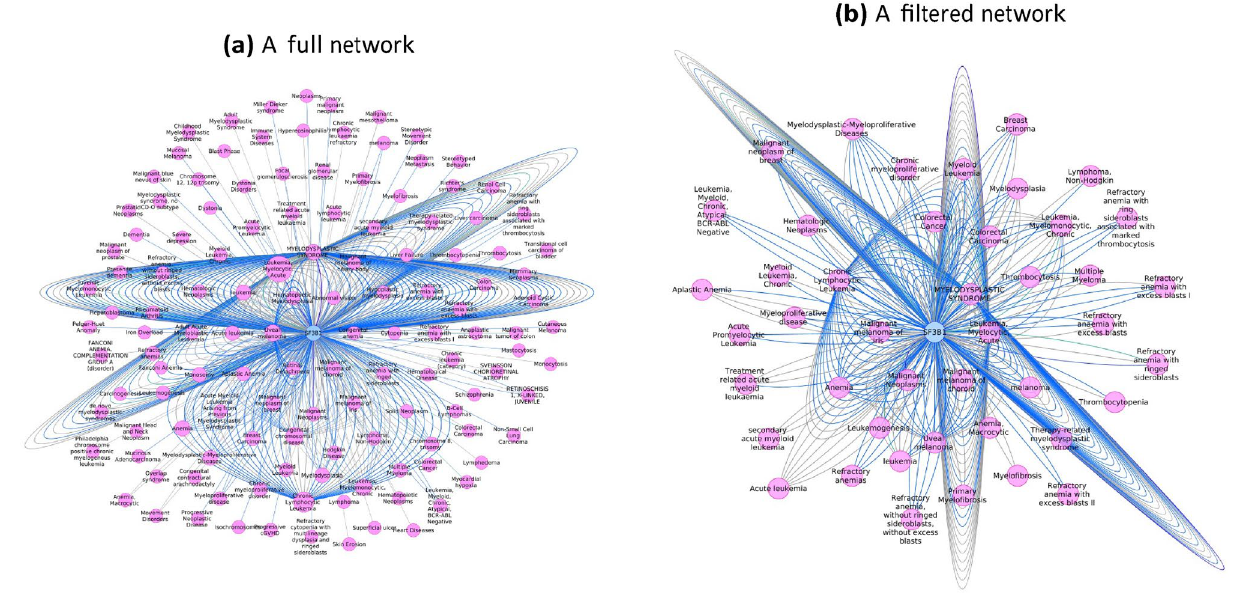
are connected to SF3B1 by 349 edges. Edges are colored based on association type; blue indicates biomarker association and gray indicates causal mutation or somatic causal